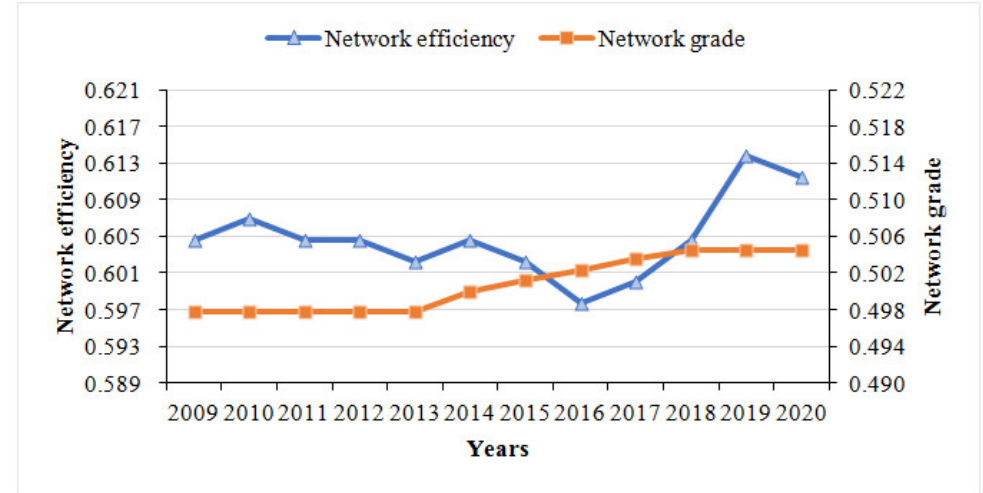
Figure 3. Trend of network efficiency and network rank degree from 2009 to 2020. Table 1. Network centrality